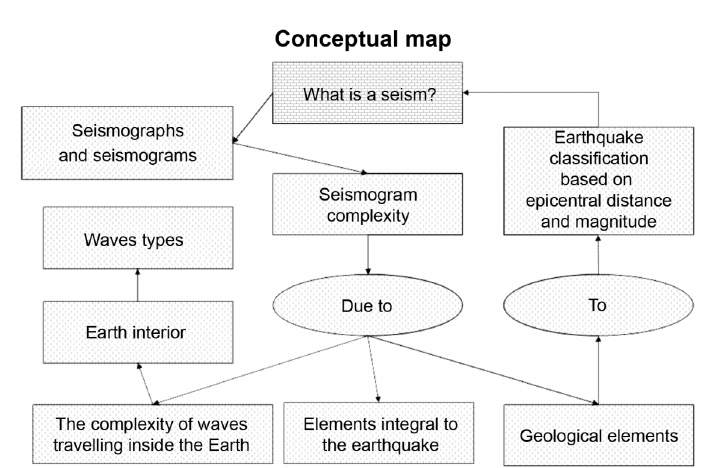
Fig. 3. An example of a typical product produced by the students in the 1st phase of the process. The products are included on the website and made available for the